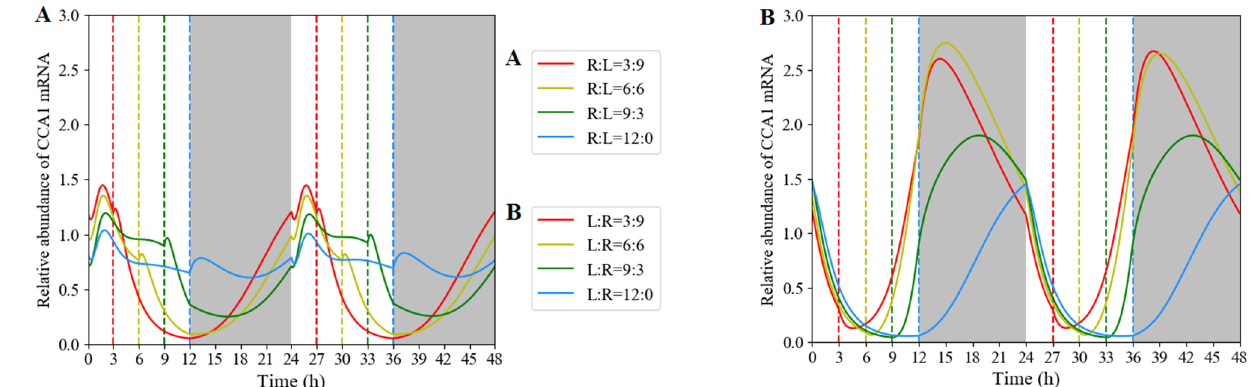
Figure 9. Simulated expression of CCA1 transcript under various red/white and white/red cycles in 12 h light interval with fixed 12 h darkness. The advanced red-light input ( A ) and advanced white-light input ( B ) were entrained to different red-light/white-light/dark photoperiods, where red light ranged from 3 to 12 h in increments of 3 h. R:L = 3:9 (red vertical dashed lines in panel ( A ) and L:R = 3:9 (red vertical dashed lines in panel ( B ) represent 3 h red light/9 h white light/12 h dark and 3 h